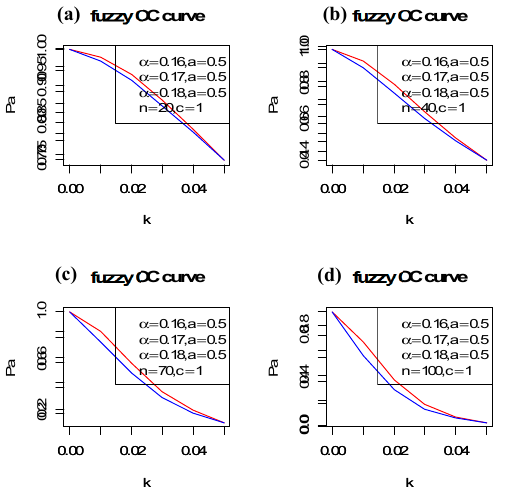
Figure 2. The fuzzy operating characteristic (OC) curve of Birnbaum-Saunders distribution at c = 1, mean ratio = 0.5, ( a ) n = 20, ( b ) n = 40, ( c ) n =70, and ( d ) n =100.